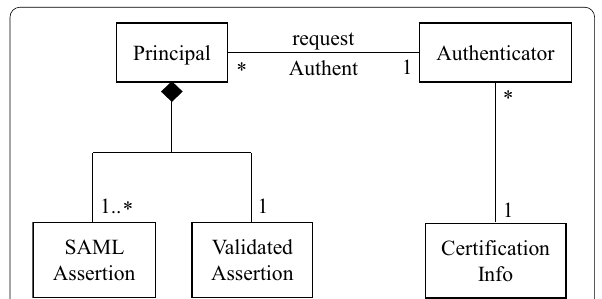
Fig. 6 Class model of the SAML-based authenticator